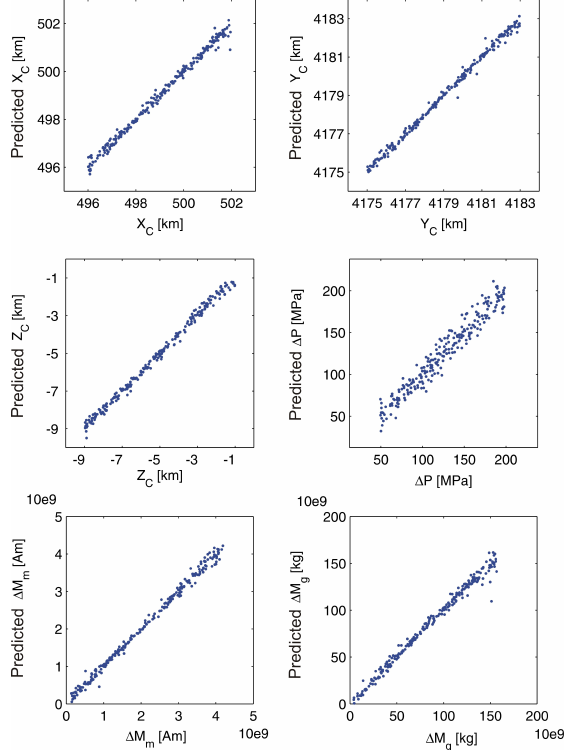
Fig. 4. Predicted values of source parameters with respect to output patterns of the testing set for the integrated numerical inversion.